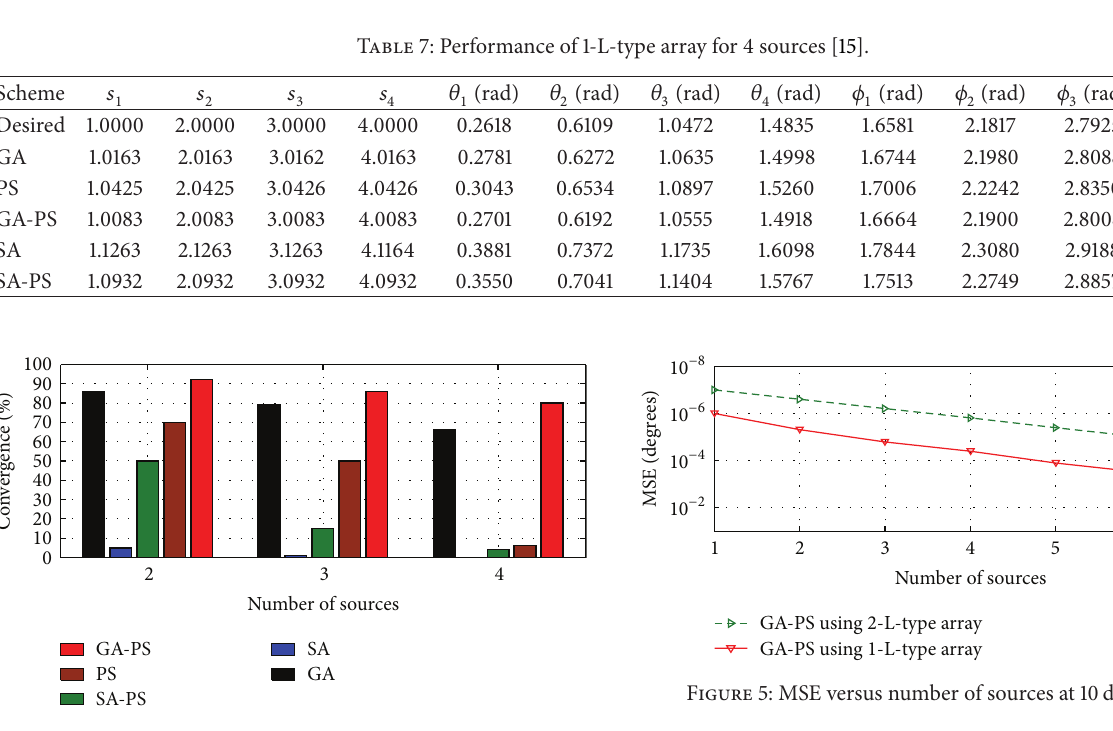
Figure 4: Convergence rate versus number of sources for 1-L-shape array at 10dB noise.